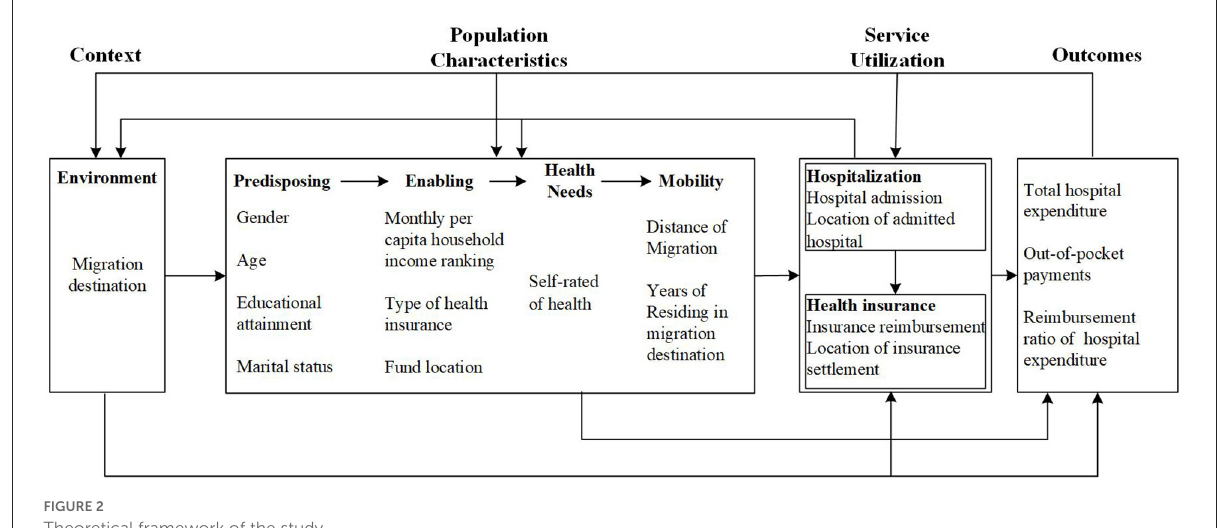
FIGURE2 Theoretical framework of the